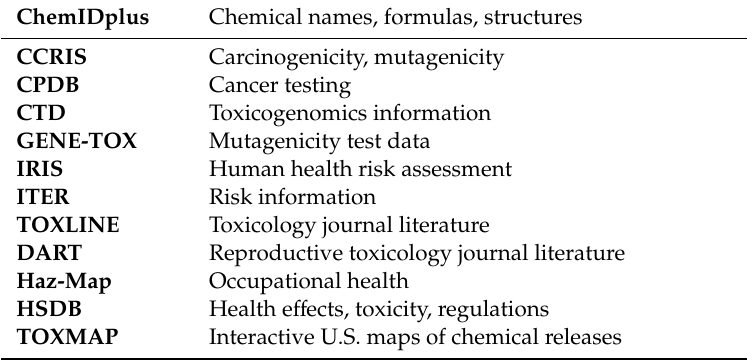
Table 2. The databases able to be access TOXINET, and their covered fields [64].